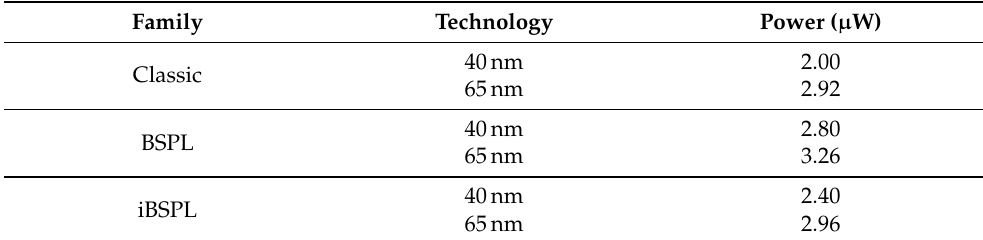
Table 5. Average power consumption for one clock